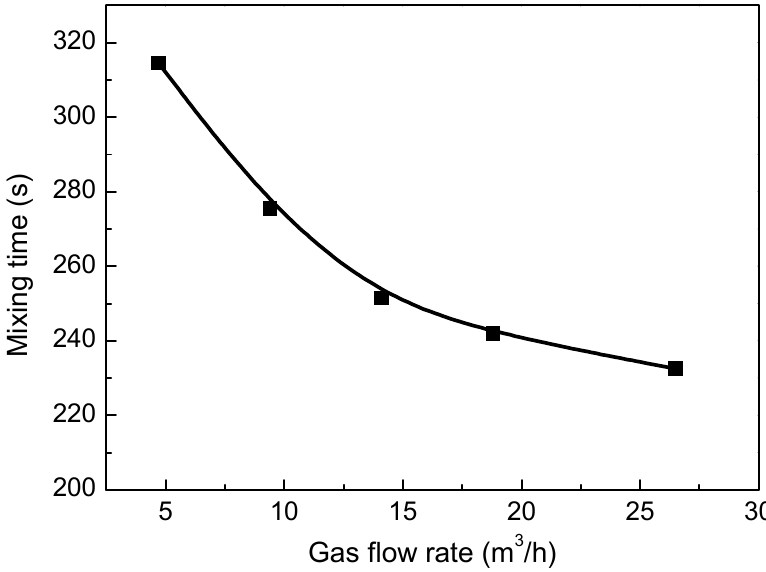
Figure 17. The effect of different gas flow rate on the predicted mixing time in the bath. Figure 17. The e ff ect of di ff erent gas flow rate on the predicted mixing time in the bath.